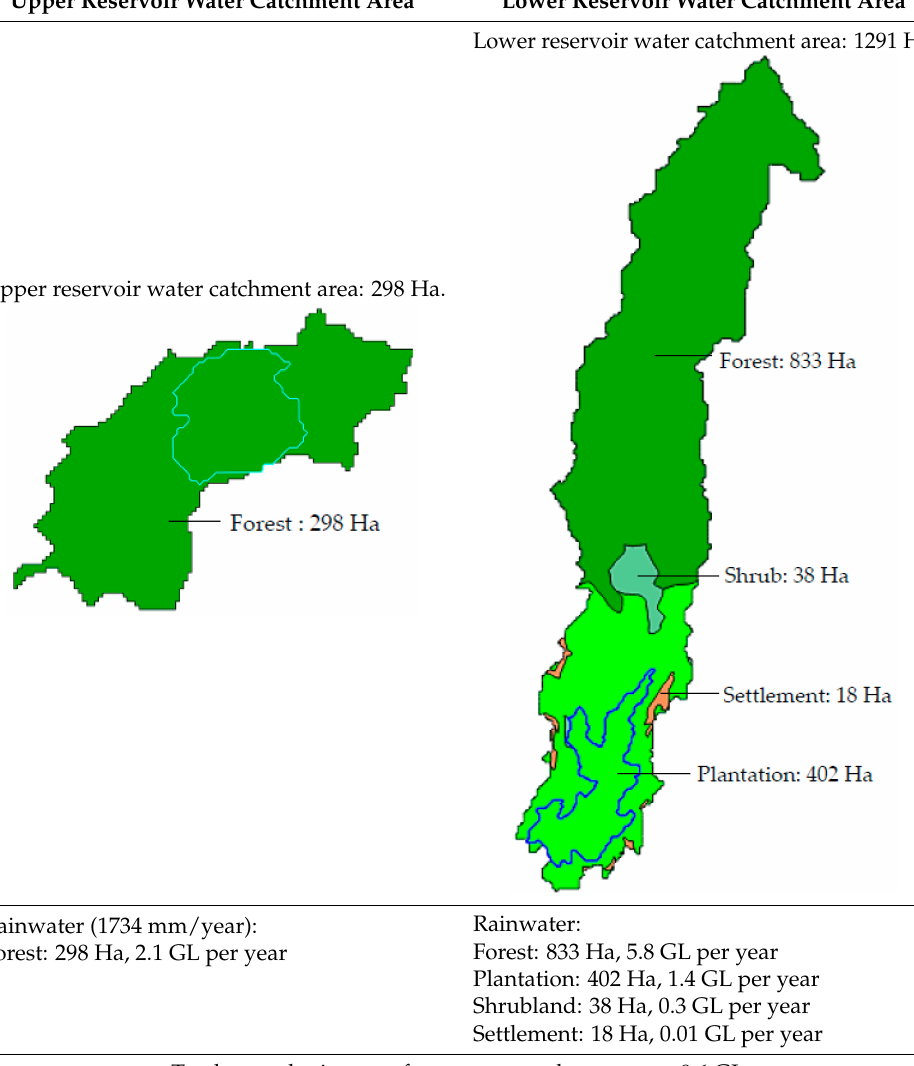
Upper reservoir water catchment area: 298